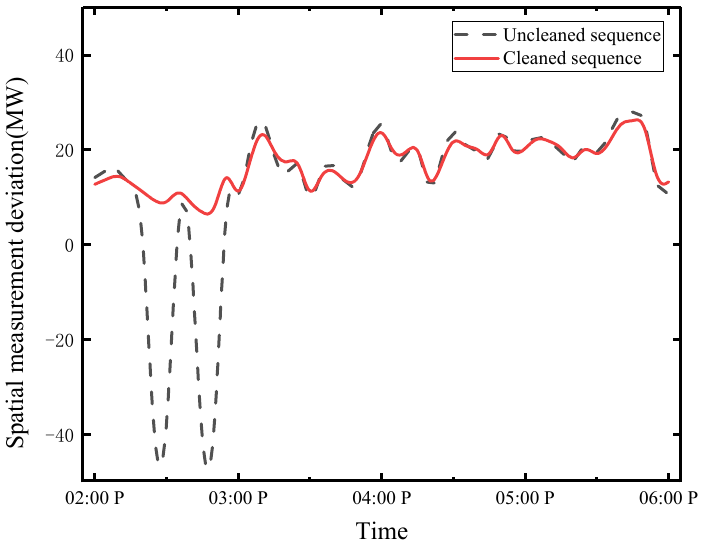
Figure 13. Comparison of the 29th sky interval measurement deviation before and after filtering. Finally, after the joint space–time filtering and cleaning, the active power curve measured by the FTU is shown in Figure 14.